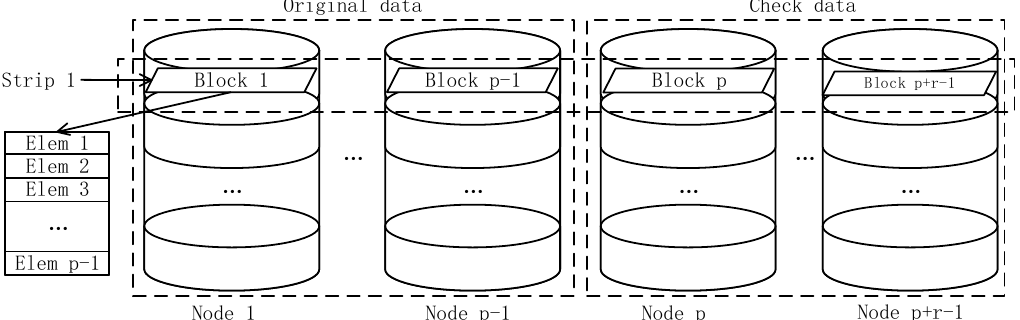
Figure 3. Logical Relationship of Data Partitioning.